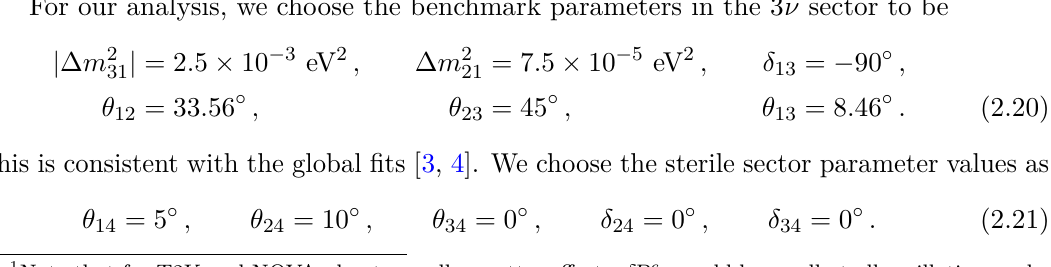
Figure 1 . The values of δP s [left] and E amplitude of δP s